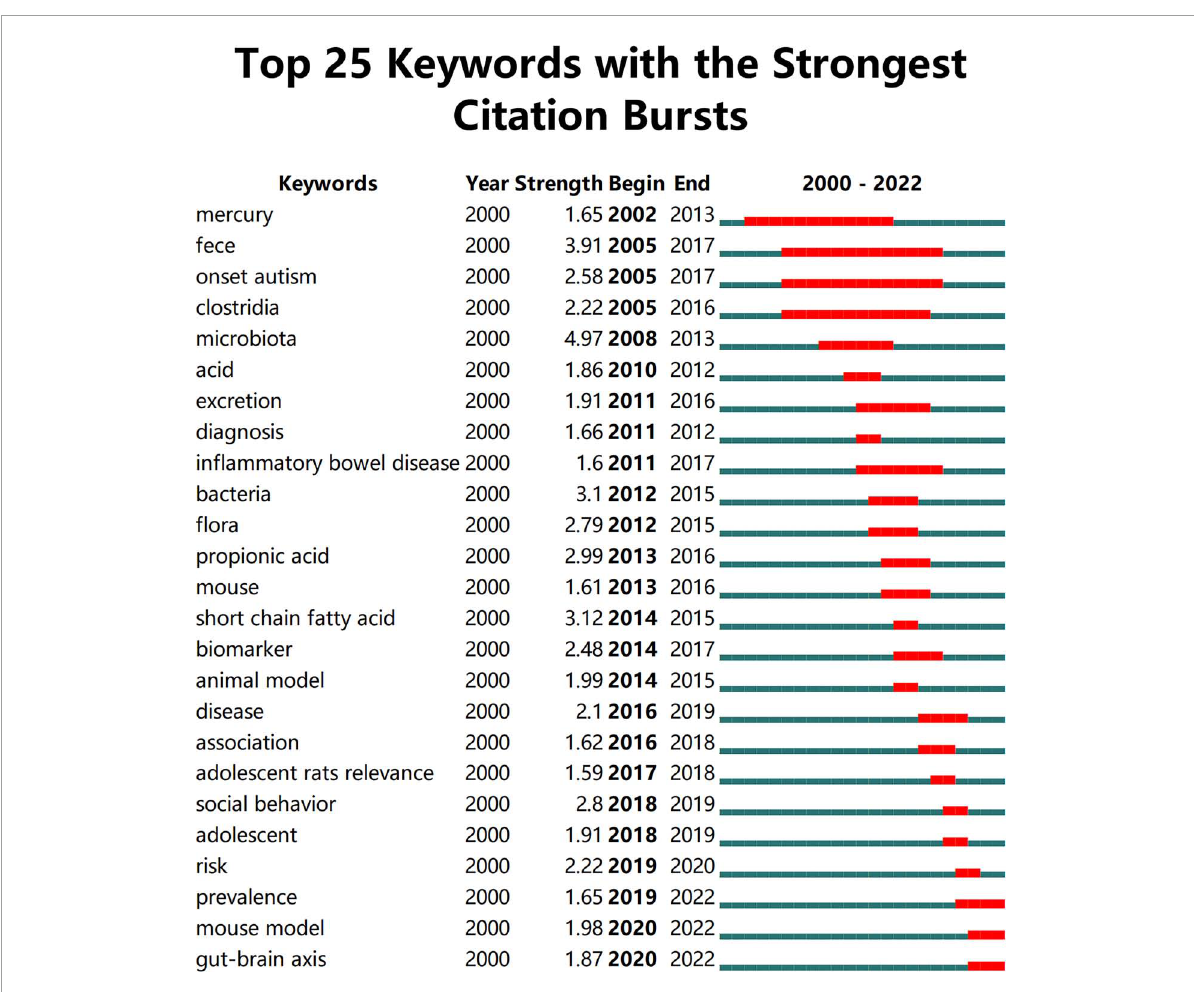
FIGURE9 The top 25 keywords with the strongest citation bursts. The strength values indicate the frequency of citation. The red bars indicate the time period in which the keyword